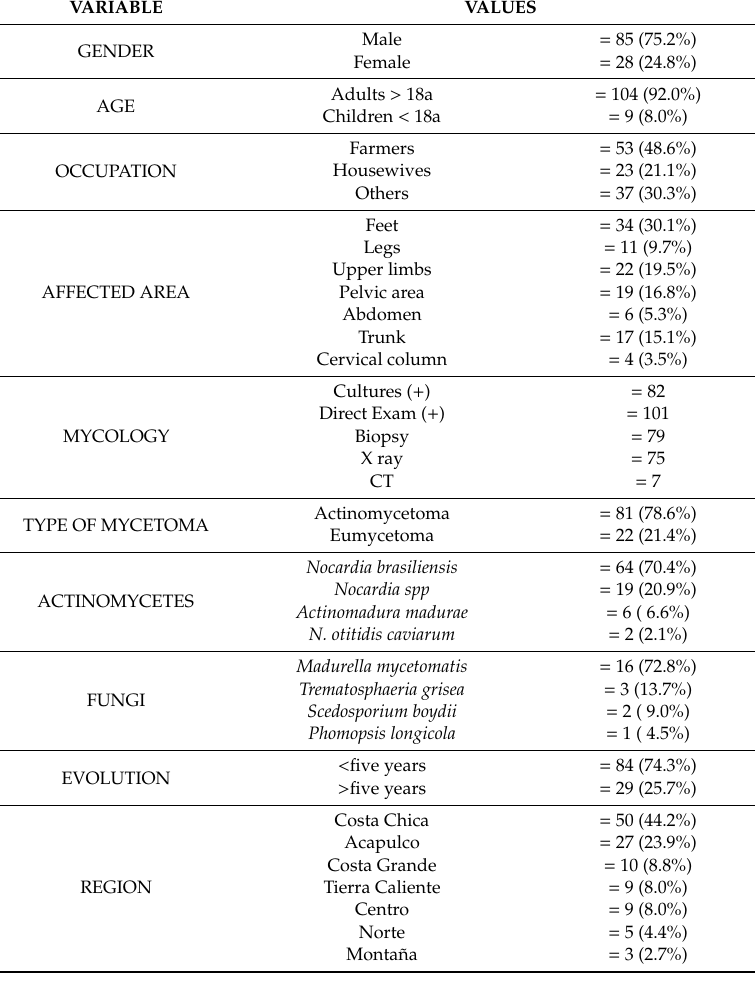
Table 1. Mycetoma